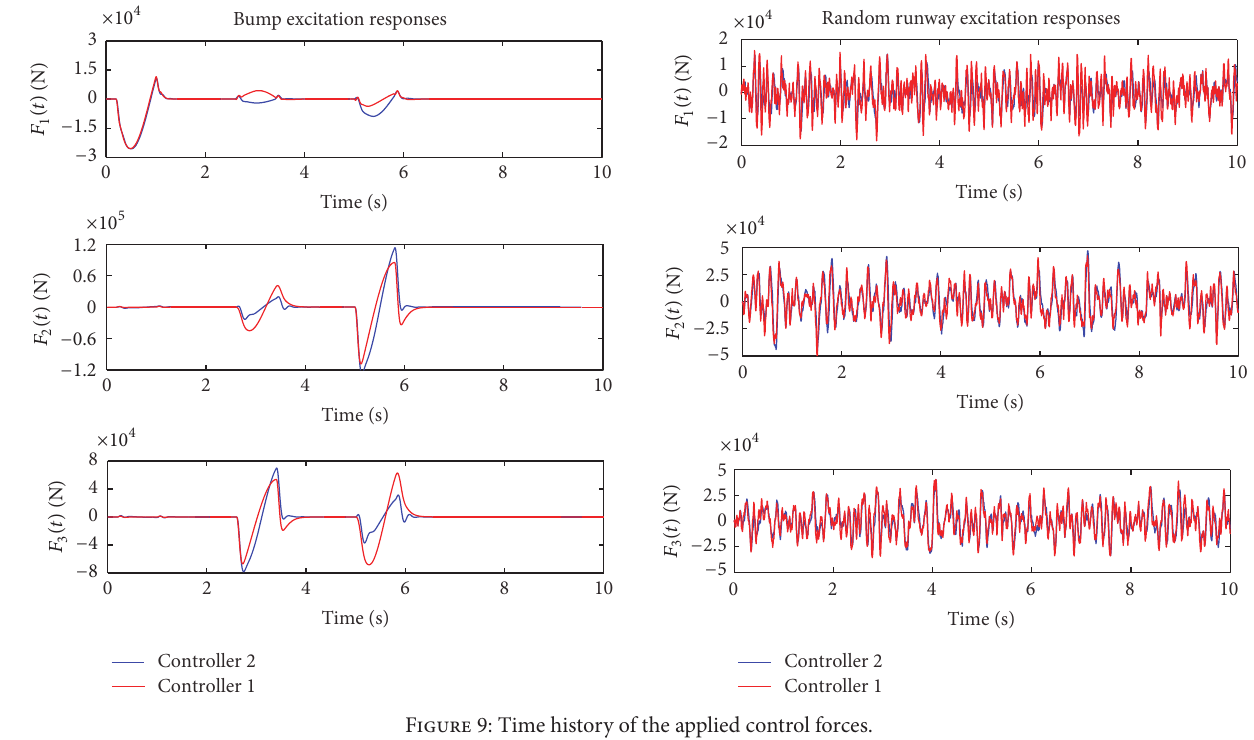
Figure 9: Time history of the applied control forces.